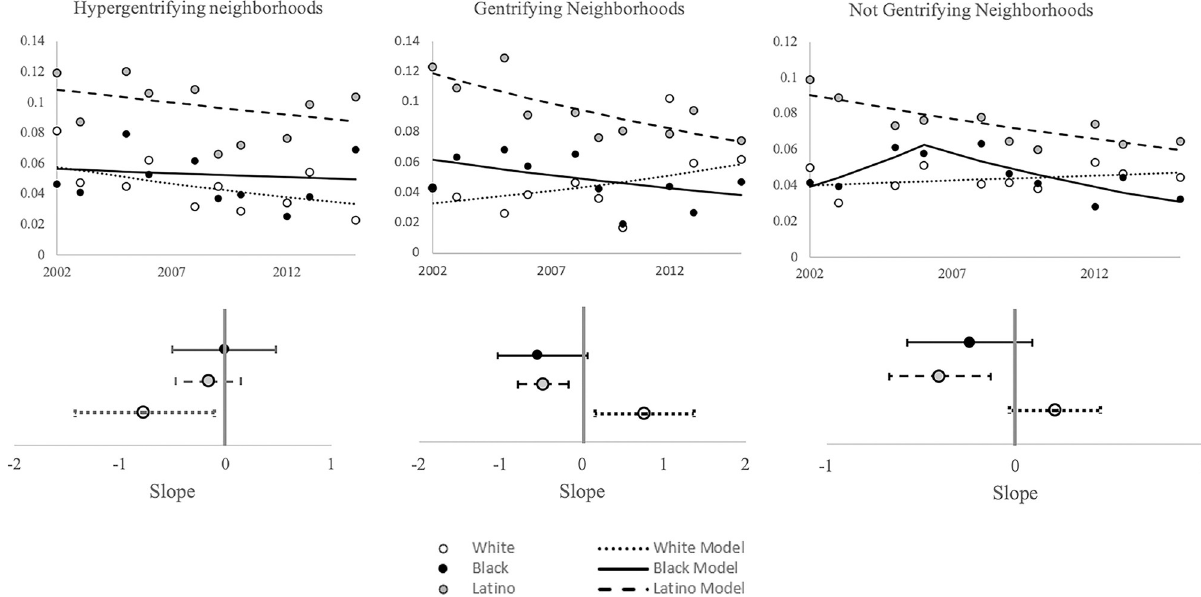
Fig 2. Time trend analysis of the prevalence of serious psychological distress by level of gentrification and race/ethnicity, New York City, 2002– 2015. These analyses were conducted using Joinpoint autocorrelated errors regression models (Top Row) and generalized logistic regression models (Bottom Row). Data from the New York City Community Health